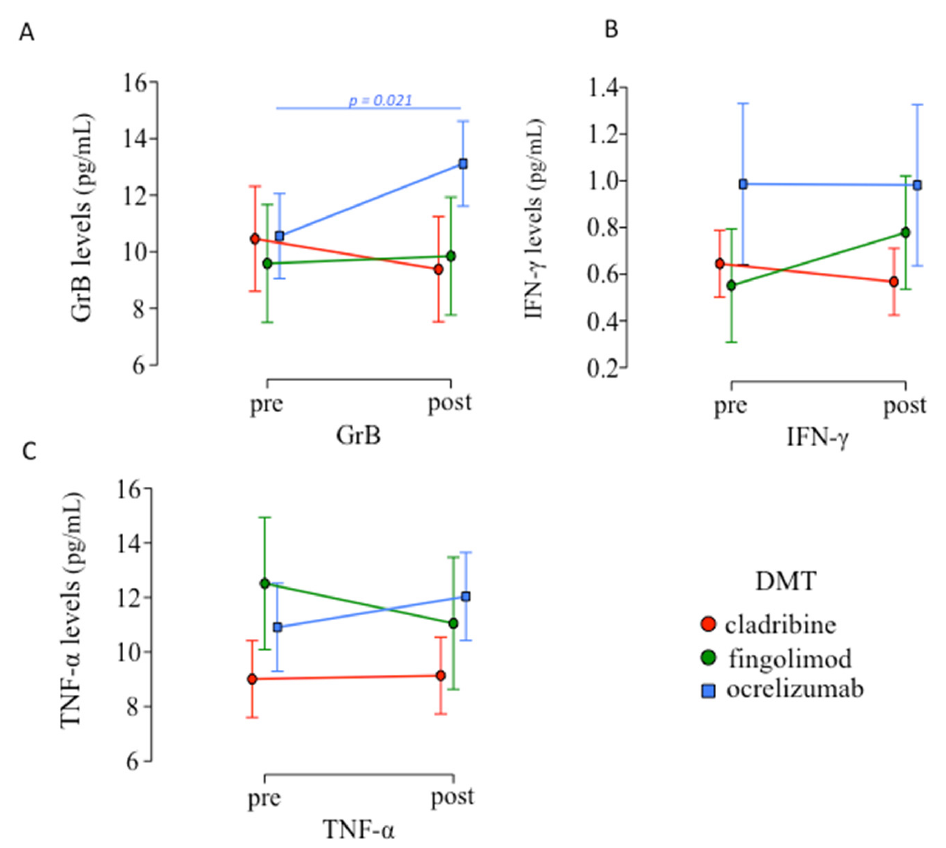
Figure 2. Inflammatory mediators’ levels pre- and post-vaccination. ( A ) A significant increase in GrB serum levels was observed only in o-pwMS after vaccination (mean ± SD: 13.115 ± 4.407)